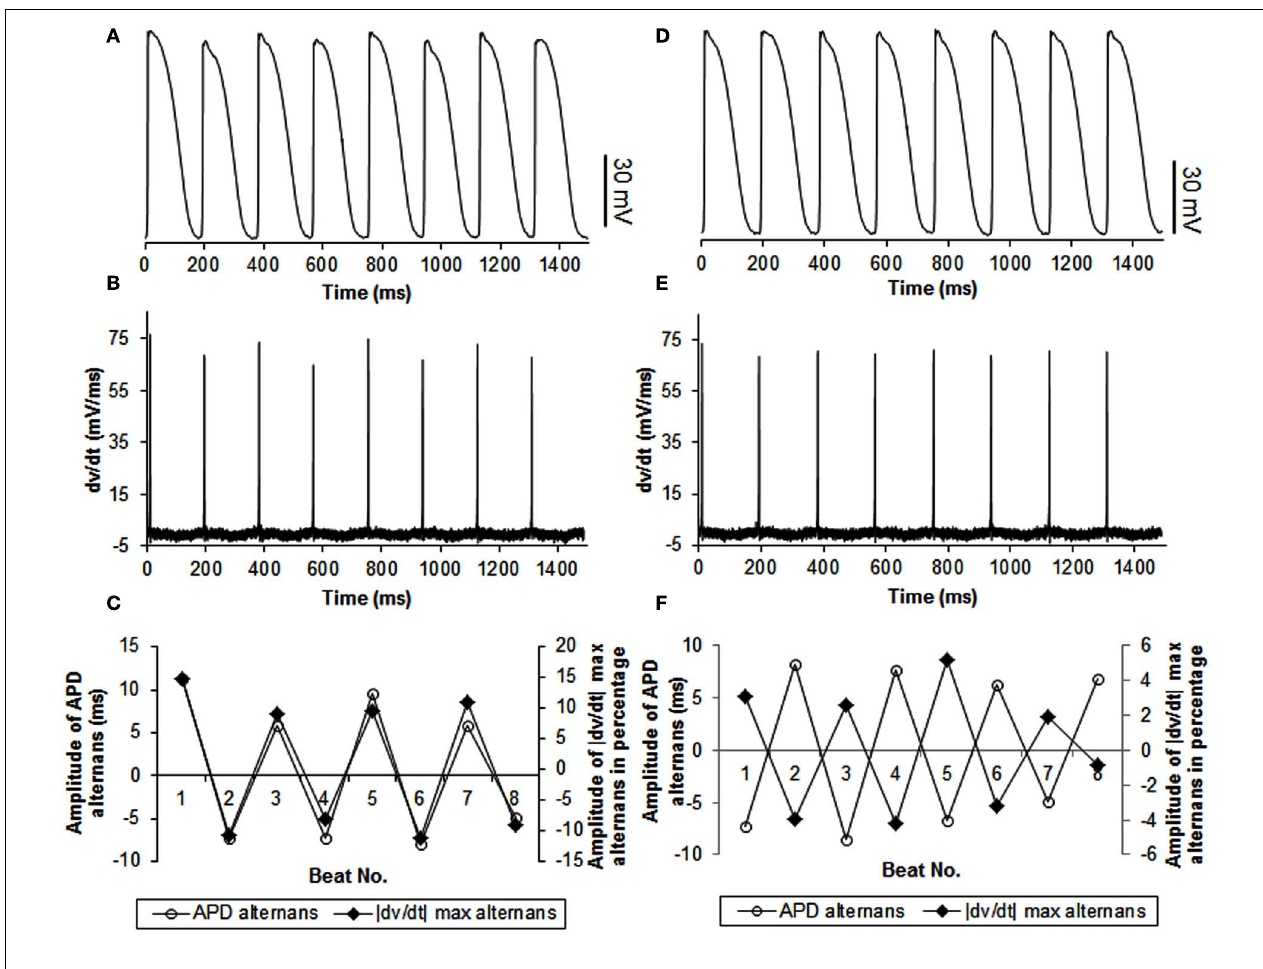
FIGURE 4 | Example of continuous recordings, during constant CL pacing, showing in phase (A–C) and out of phase (D–F) relationship betweenAPD and |d v /d t | max alternans in swines.